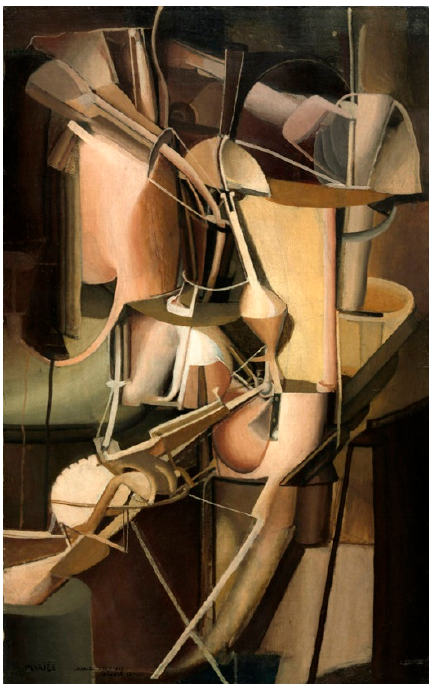
Figure 2. La Mariée (The Bride) by Marcel Duchamp, 1912. Oil on canvas, 89.5 cm × 55.6 cm. Philadelphia Museum of Art, The Louise and Walter Arensberg Collection, 1950 . © Artists Rights Society (ARS), New York/ADAGP, Paris/Succession Marcel Duchamp and used by permission.